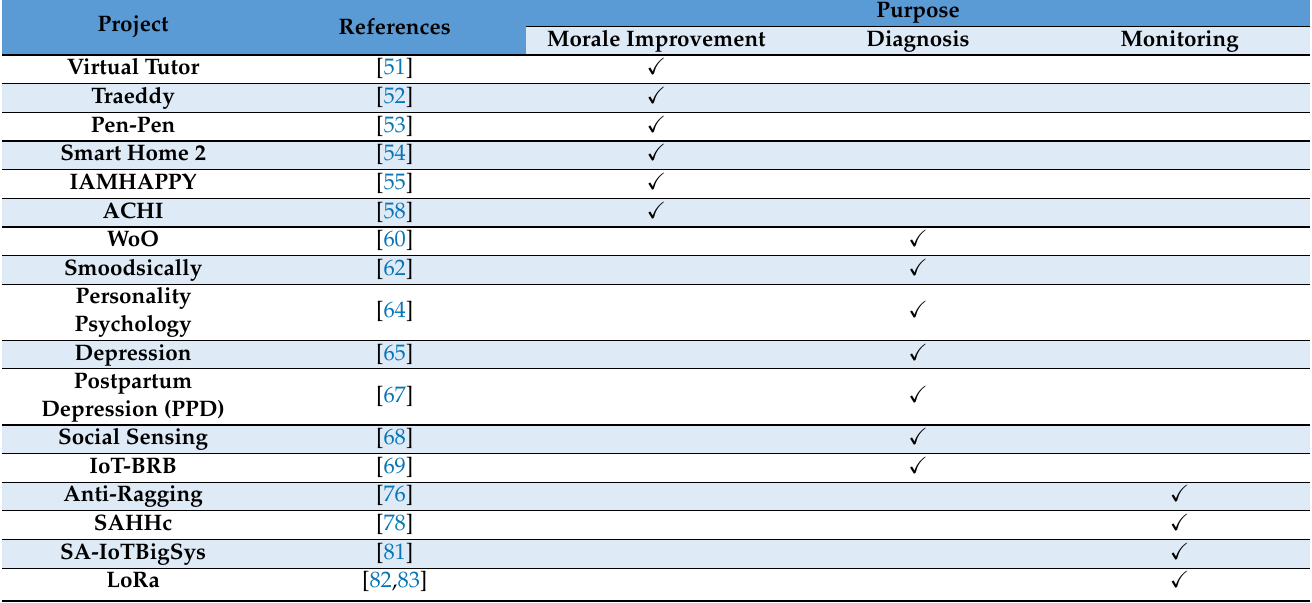
Table 1. Summary of IoT-based psychological projects from the perspective of